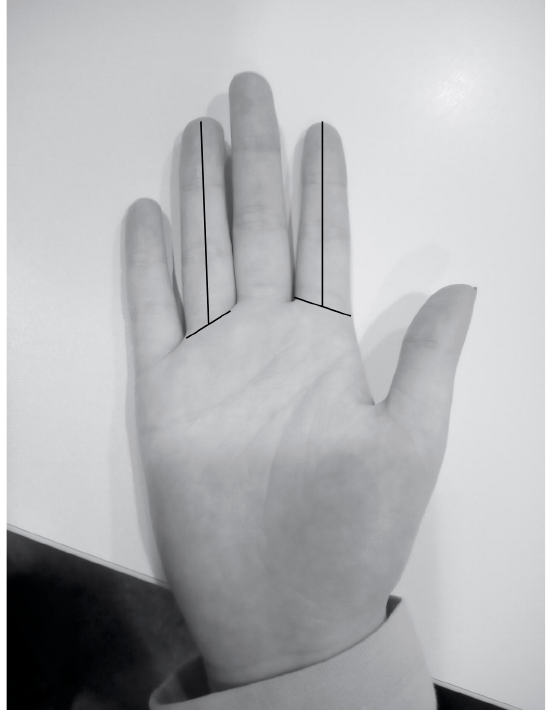
Figure 2. Measurement of 2D and 4D fingers in a PWS female participant.